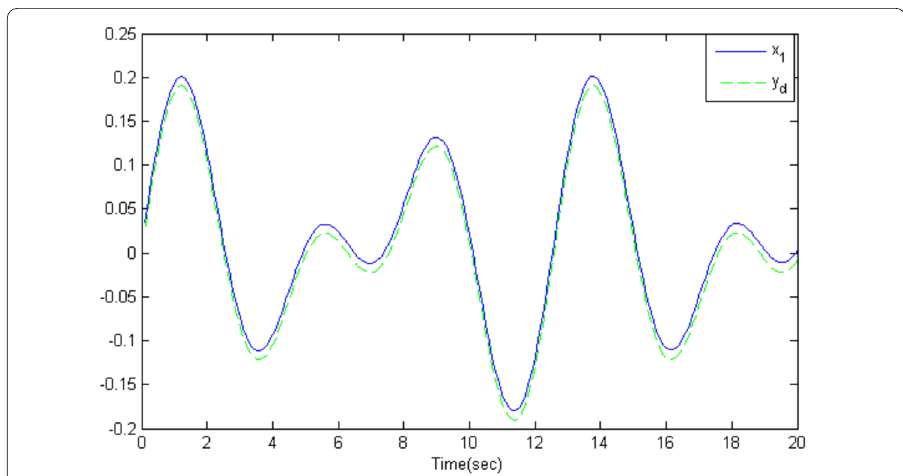
Figure 7 Another compared tracking performance of